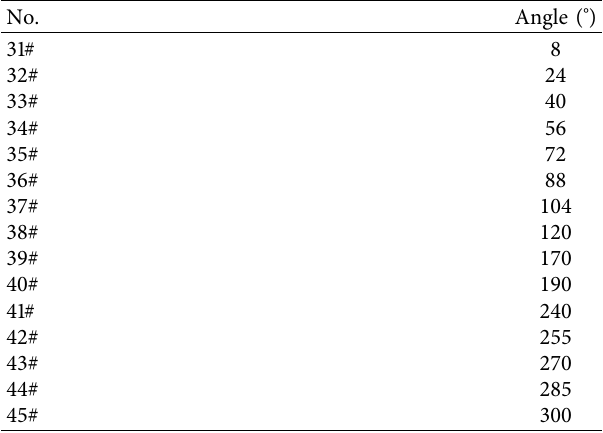
Figure 6: Arrangement diagram of pressure measurement point. Table 1: Geometric coordinates of the circumferential pressure measurement point on cross-section of centrifugal pump